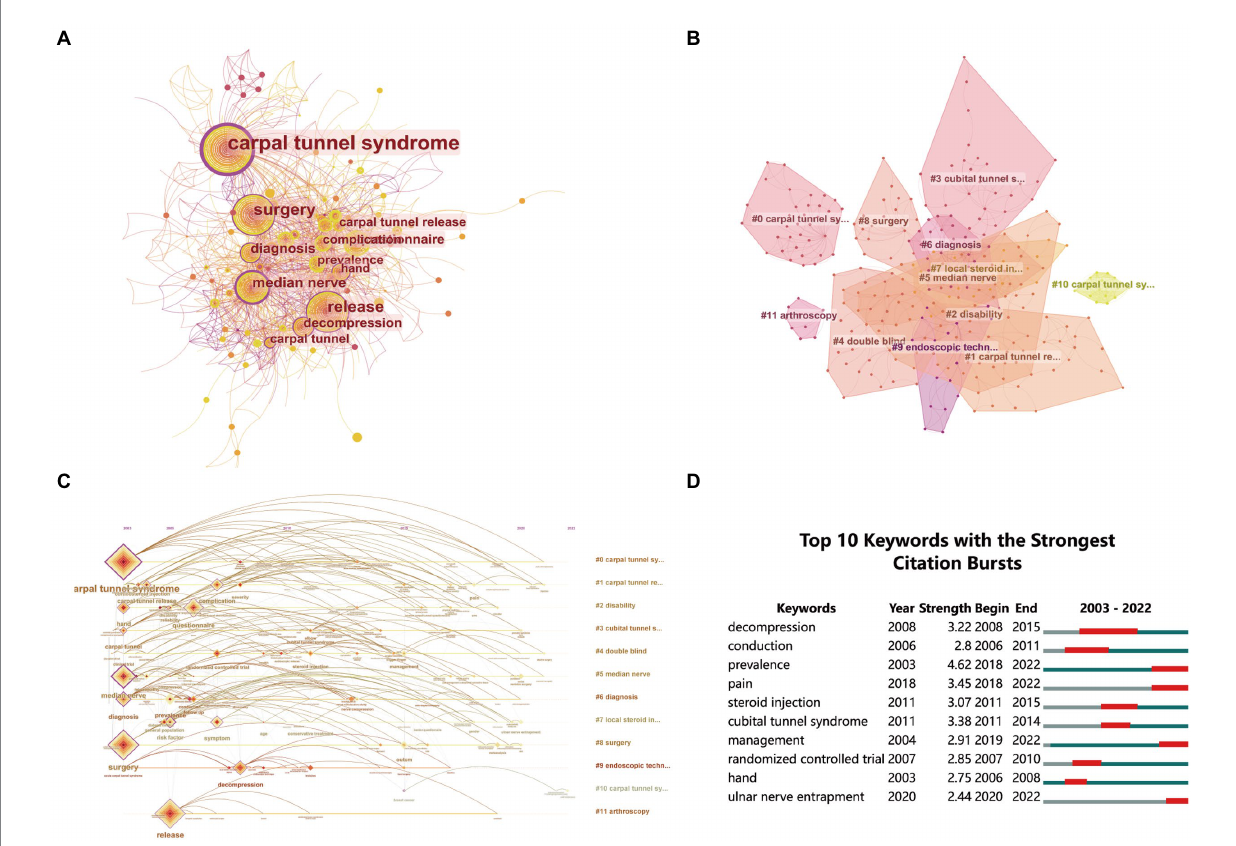
FIGURE 4 Keyword analysis of research areas on surgical treatment of CTS from 2003 to 2022. (A) Keyword co-occurrence network. (B) Keyword clustering analysis. (C) Keyword clustering timeline diagram. (D) The plot of keyword burst curves.